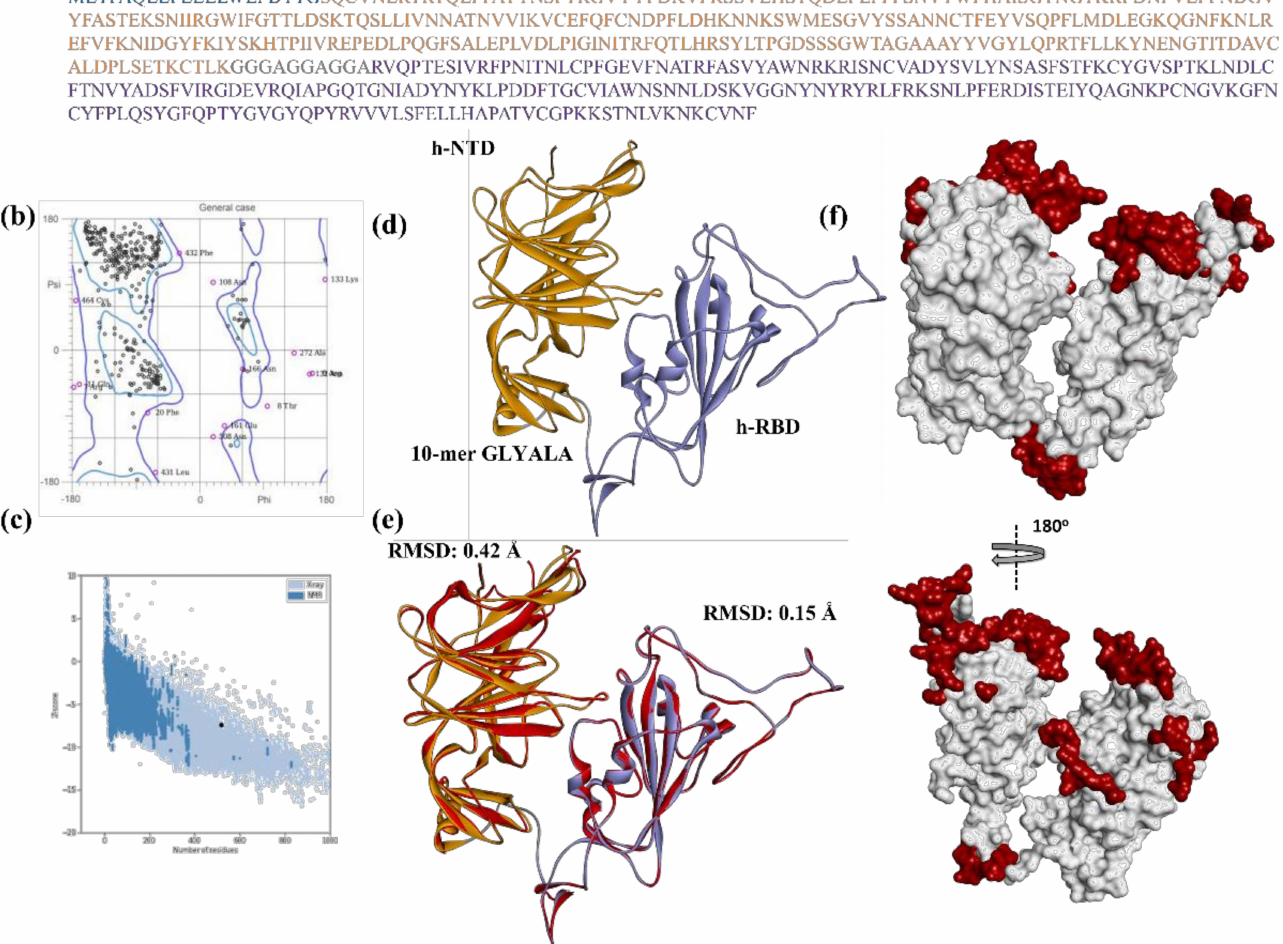
Figure 4. Sequence and structure of designed mRNA construct encoded protein (DOW-21). ( a ) Schematic representation and amino acid sequence of designed mRNA encoded protein (DOW-21) showing distribution of signal sequence (cyan), h-NTD (orange), and h-RBD (purple), intervened by gly-ala linker. ( b ) Ramachandran plot showing distribution of dihedral angles (black dots) of DOW-21 protein model in the favored (blue contour) and allowed (purple contour) regions. ( c ) Z-Score of DOW-21 model (black filled circle) in the Z-score graph of empirically resolved protein structures deduced by NMR (dark blue) and X-ray crystallography (light blue). ( d ) Ribbon diagram of DOW-21 model showing h-NTD, gly ala linker, and h-RBD in corresponding colors. ( e ) Ribbon diagram of DOW-21 superimposed with SARS-CoV-2/Wuhan NTD and RBD with RMSD values mentioned. ( f ) Distribution of epitope (maroon) in the surface topology of DOW-21 with 180 o rotation showing retention of the antigenic regions as found in the NTD and RBD of multiple SARS-CoV-2